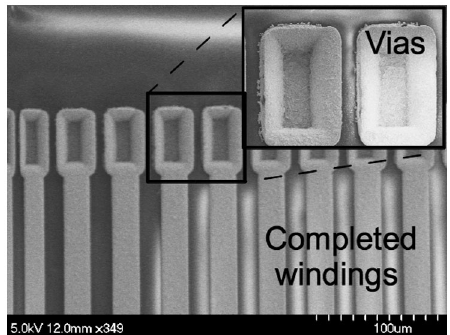
FIG. 14. Scanning electron micrograph of completed windings and vias. The inset shows a more detailed view of the filling of the